Question: Generate an informative caption for the figure above.
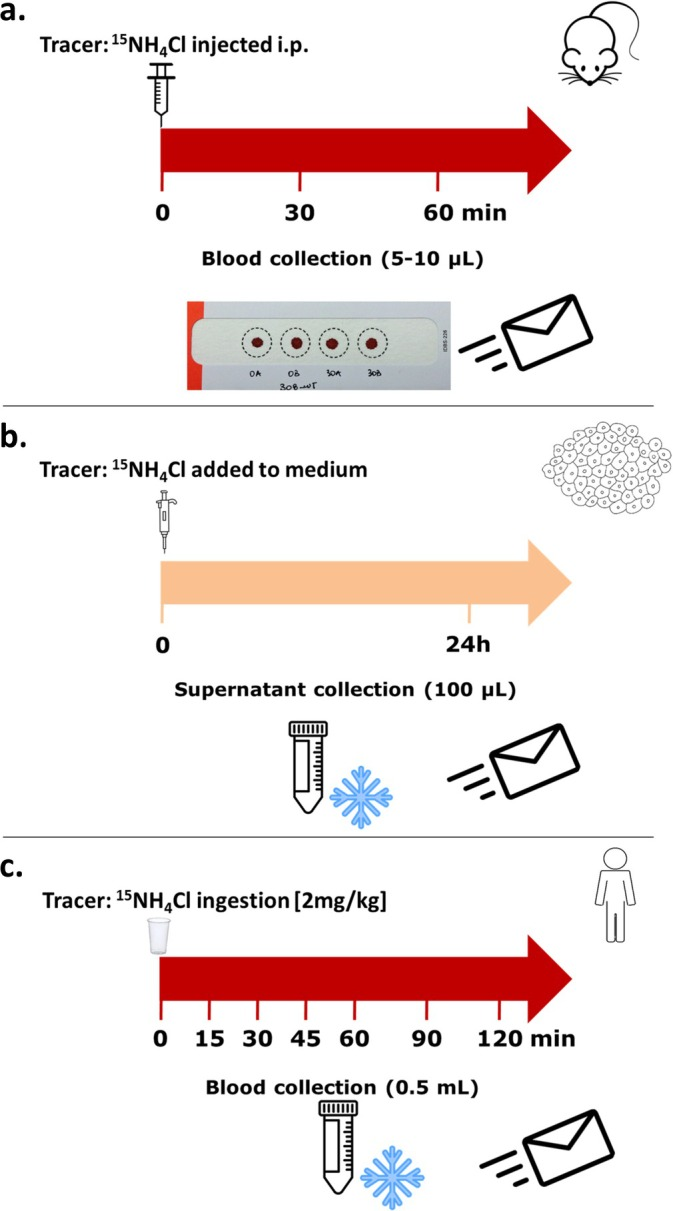
Answer: The figure shows in a simplified way the practical aspects of the ureagenesis assay when performed in mice (a) or cells (b); for comparison, the assay procedure is also shown for humans (c, modified from b, in [ 12 ]). ip, intraperitoneal.